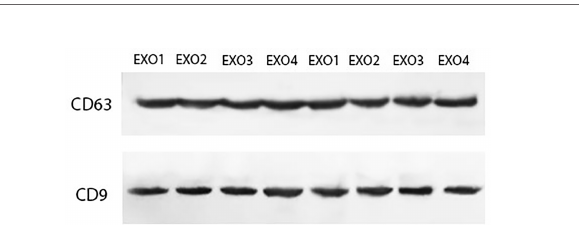
FIGURE 2 | Characterization of hepatocyte-derived exosomes using Western blotting. Hepatocyte cell-derived exosomes were analyzed by Western blotting using antibodies against exosomal markers (CD9